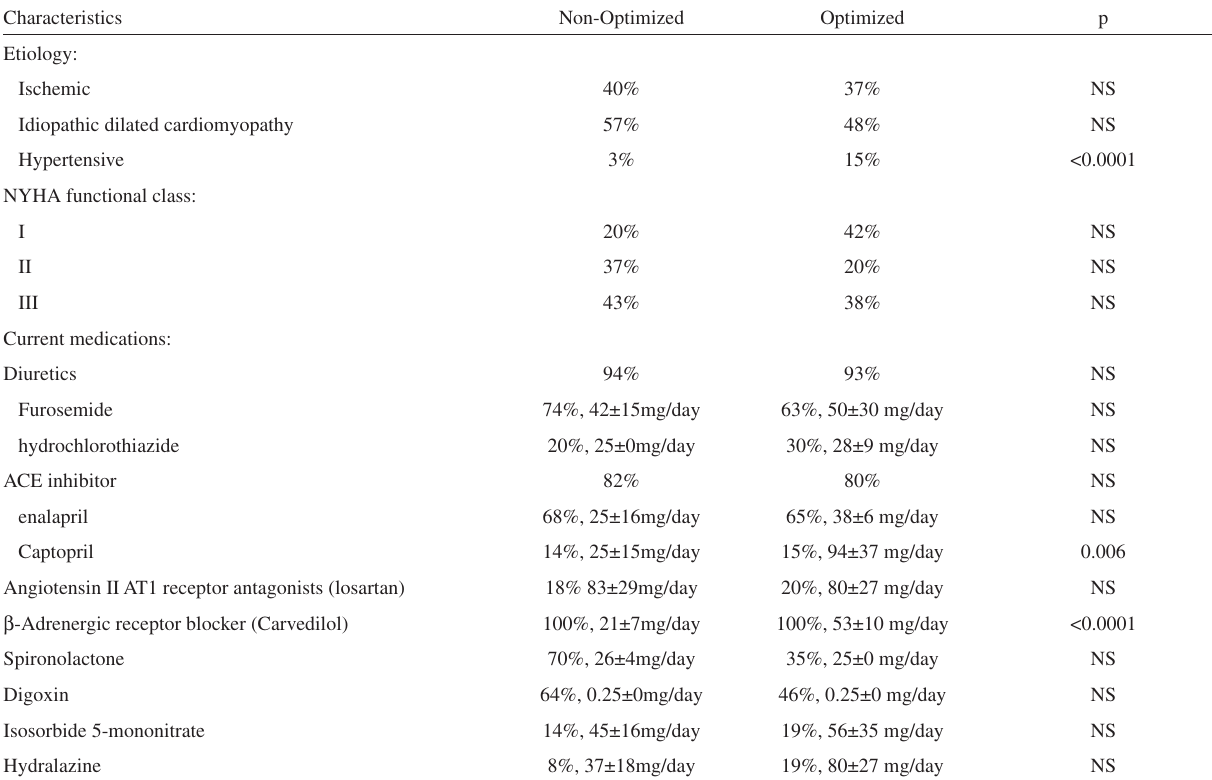
Table 1 - Characteristics of the heart failure patients